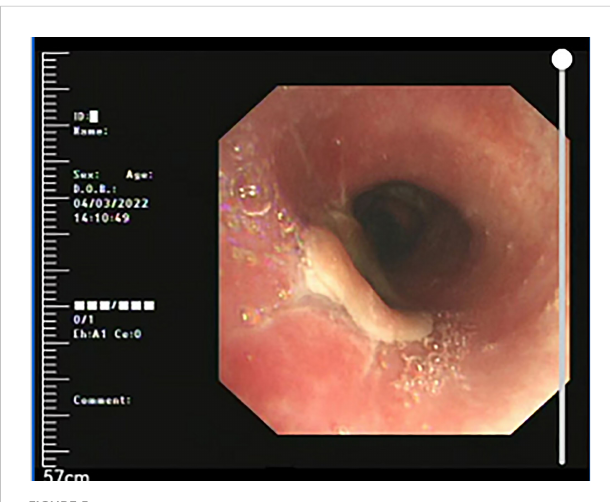
FIGURE 6 Hematoxylin and eosin staining revealed large cells with cytoplasmic